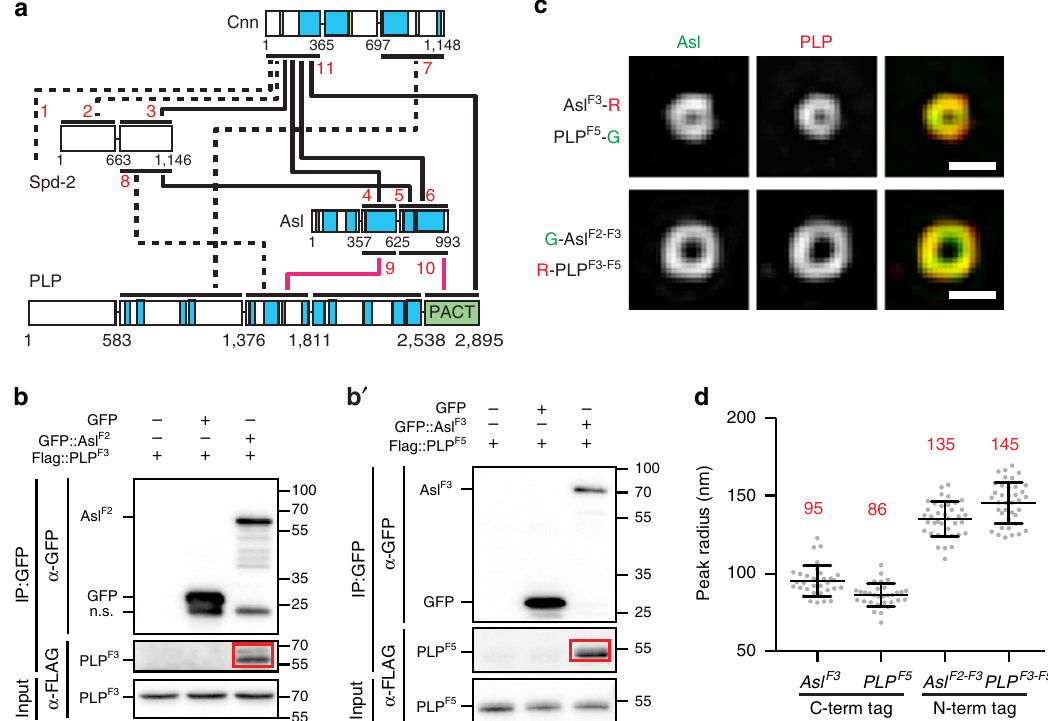
Figure 4 | PCM protein interactions predict position and function. ( a ) PPIs among PCM proteins. Numbers refer to Y2H data in Supplementary Fig. 5a. Pink lines highlight interactions confirmed in b , b 0 . Schematics as in Fig. 2a. ( b , b 0 ) Co-IP confirmation of Asl F2 (aa 358–625)/Plp F3 (aa 1,377–1,811) and Asl F3 (aa 626–993)/Plp F5 (aa 2,539–2,895) interactions (interactions 9 and 10 from a ). Red box highlights co-IP’ed protein. Sizes are in kD. ( c ) SIM of representative centrioles from S2 cells expressing the tagged Asl and Plp fragments diagrammed in Supplementary Fig. 5b. Both of the regions of the two proteins that interact are in close proximity to each other on centrioles. ( d ) Radius of the N- and C-termini of Asl and PLP on centrioles (as in c ). Peak radius measurements showing the mean (red number) ± s.d., Ns are centrioles—Asl F3 ¼ 32, PLP F5 ¼ 31, Asl F2–F3 ¼ 38, PLP F3–F5 ¼ 38, pooled from two experiments. Scale bars,